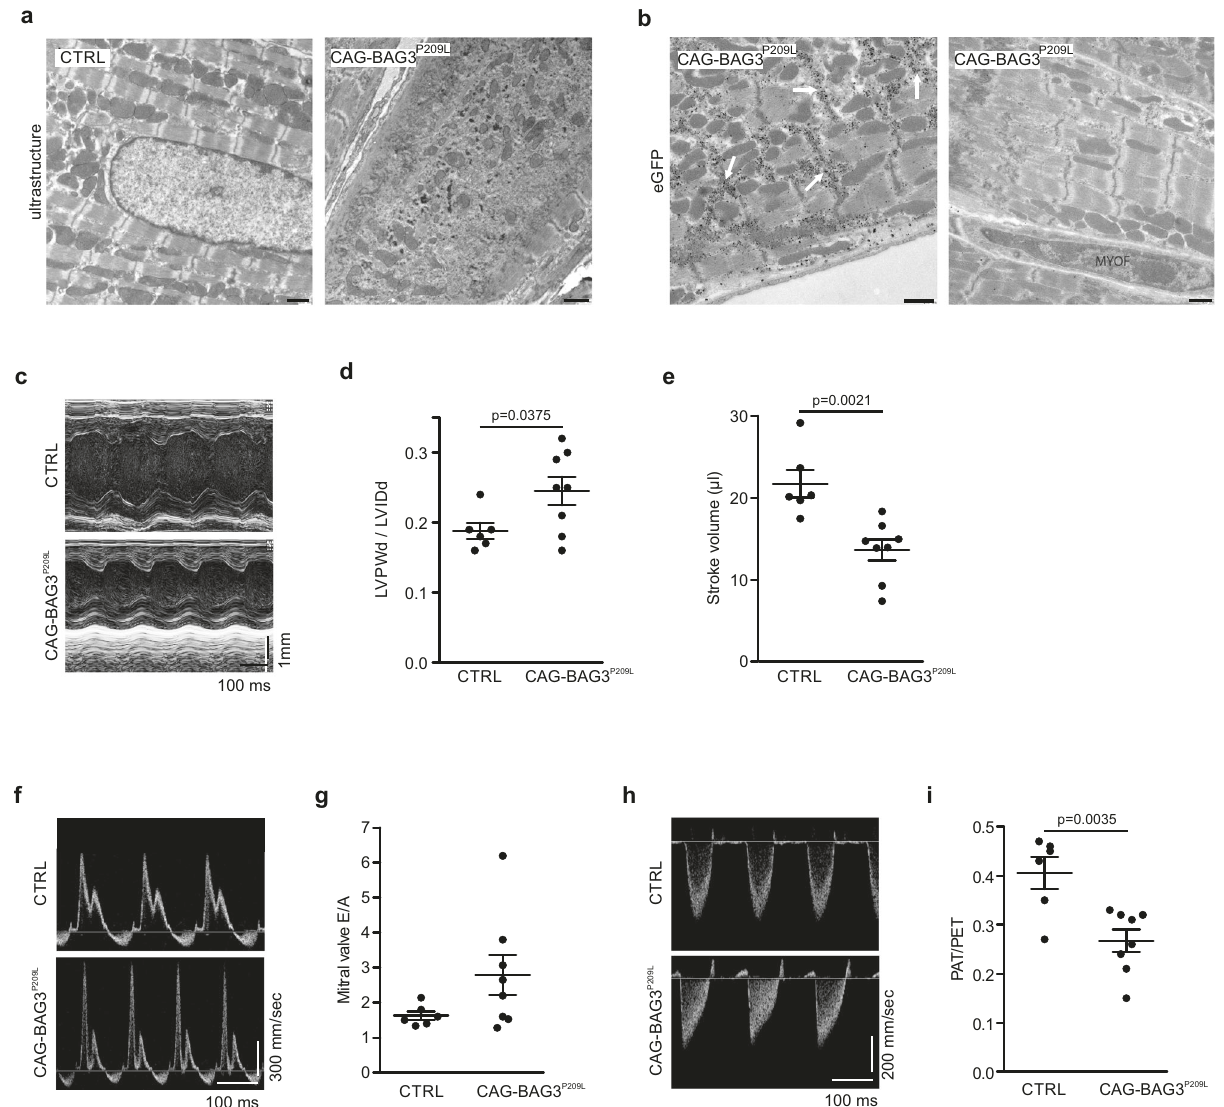
Fig. 4 Disintegration of sarcomeres and development of restrictive cardiomyopathy in CAG-BAG3 P209L mice. a , b Ultrastructural analysis of hearts from 4-week-old control and CAG-BAG3 P209L mice ( a ) and ( b ) immunogold staining for eGFP, revealing disintegration of sarcomeres and formation of aggregates in CMs from CAG-BAG3 P209L mice (arrows). MYOF = myo fi broblast. Scale bars: 1000 nm. The experiments were repeated three times from three independent biological replicates with similar results. c – i Echocardiography of 4-week-old CAG-BAG3 P209L and CTRL mice: c – i Increased relative wall thickness ( c , d ) and reduced stroke volume ( c , e ) were found in CAG-BAG3 P209L mice; data were obtained from parasternal M-Mode of the left ventricle. Tendency of increased mitral valve E/A ratio ( f , g ) and increased pulmonary artery acceleration/ejection time (PAT/PET; h , i ) were found in CAG- BAG3 P209L mice; data were derived from Doppler fl ow measurements. LVPWd left ventricular posterior wall during diastole, LVIDd left ventricular inner diameter during diastole. Mean ± SEM. ( d , e , g , i ) n = 6 CTRL and 8 CAG-BAG3 P209L mice. Two-sided Student ’ s T -test. CTRL, control mice (siblings of CAG-BAG3 P209L mice, which are either WT, PGK-Cre, or CAG- fl ox-hBAG3 P209L